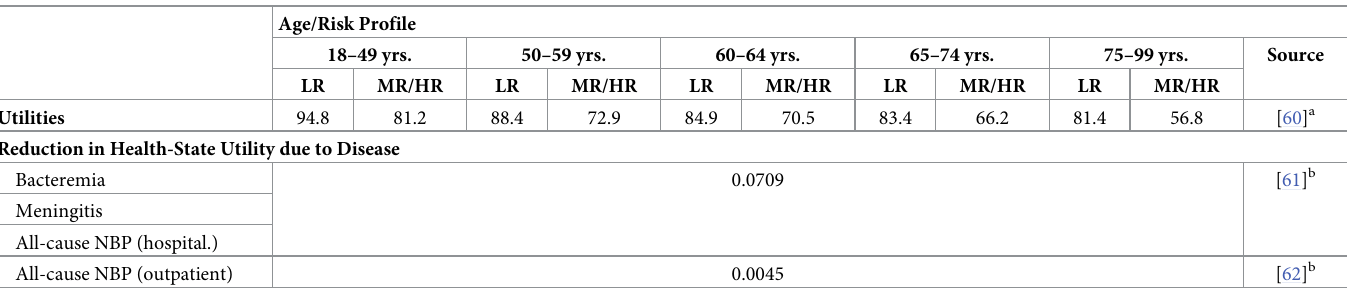
Table 5. Age and risk level specific utilities.